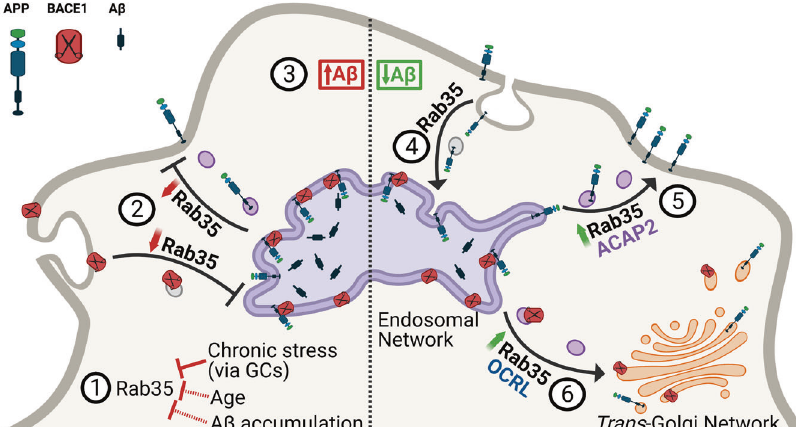
Fig. 7 Working model summarizing the interplay between Rab35 and stress/GC on APP traf fi cking and processing. AD etiopathological factors such as advanced age, A β accumulation, or exposure to chronic stress and/or high levels of glucocorticoids (GC), lead to a signi fi cant reduction of Rab35 levels [1]. This reduction inhibits APP and BACE1 recycling with the plasma membrane [2], increasing APP-BACE1 association in the endosomal network and stimulating amyloidogenic APP processing and A β production [3]. Alternatively, high levels of Rab35 promote APP internalization [4] and recycling to the plasma membrane via the effector ACAP2 [5], and in parallel stimulate BACE1 retrograde traf fi cking to the trans-Golgi network via the effector OCRL [6]. These traf fi cking events reduce APP-BACE1 interaction within the endosomal network, thereby decreasing production of APP CTFs and A β